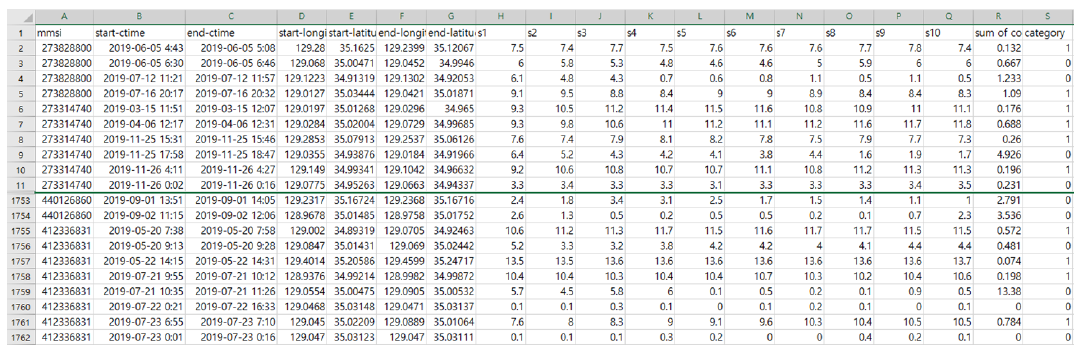
Figure 10. Preprocessing results of AIS data for fishing ships.